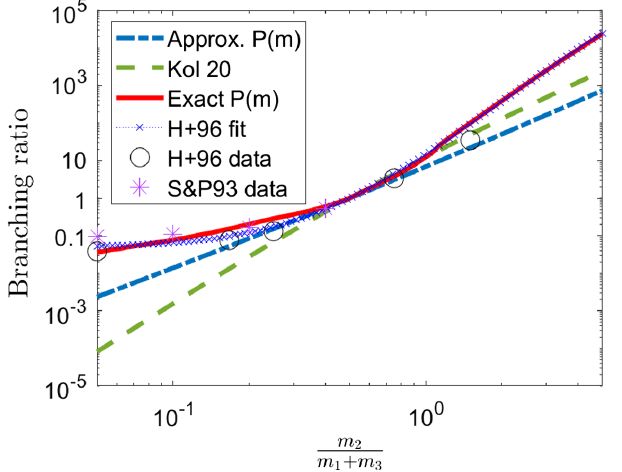
FIG. 3. Comparison between Eq. (48) and the numerical simu- interactions).FIG. 2. Predictions of Eq. (36) (sea blue, dash-dotted line), lations of Sigurdsson and Phinney [see Fig. 2(b) in Ref. [17] ]. Eq. (48) (red), integrated over the relevant range, and Eq. (A.16) The initial semimajor axis is a 0 ¼ 0 . 1 AU, and the initial of Kol [25] (green dashed line), compared with the semianalytical eccentricity is e 0 ¼ 0 ; the initial binary masses are m 1 ¼ 1 . 4 M ⊙ , fit of Heggie et al. [37] (blue, dotted with crosses) and numerical 0 . 56 M ’ s mass is m m 2 ¼ ⊙ , and the incoming third star 3 ¼ simulation data from Heggie et al. [37] (black circles) and 1 . 4 M v ffiffiffiffiffiffiffiffiffiffiffiffiffiffiffiffiffiffiffiffiffiffiffiffiffiffiffiffiffiffiffiffi p ⊙ . Its initial velocity 0 is uniformly distributed between Sigurdsson and Phinney [17] (purple asterisks). The initial binary 0 . 05 v 0 . 15 v v GM μ = ð m a . The impact c and c , where c ¼ 3 0 Þ bin masses are m 1 ¼ 1 M ⊙ and m 2 , and the incoming star ’ s mass, parameter is uniformly distributed in a disc D ð v 0 Þ at infinity, m m v 0 . 1 v v v a 4 v =v 0 . 6 ð 1 þ e 3 ¼ 1 . Its velocity is 0 ¼ c (where c is defined in the whose radius is b 0 Þ ¼ 0 ½ c 0 þ 0 Þ(cid:4) . All these max ð caption of Fig. 3) to ensure that the binary is hard. The y axis parameters were chosen to match those of Ref. [17]. We use shows the branching ratio of the cross section for ejecting m 1 β ¼ 1 . 5 , but the results are insensitive to β . The straight line relative to the cross section for ejecting m 2 . There is excellent and the data marked by blue bars pertain to the exchange agreement with Eq. ð 1 ; 2 Þ þ ð 3 Þ → ð 1 Þ þ ð 2 ; 3 Þ , while the dashed-dotted line and the data marked by purple bars are for the process ð 1 ; 2 Þ þ ð 3 Þ → ð 1 ; 3 Þ þ ð 2 Þ , where the lighter star is ejected. Error bars correspond to 3 σ statistical (Poisson) errors, arising from a total integration number of 4000 (see Fig. 9 in Ref. [17]). As expected by Sigurdsson and Phinney [17], the cutoff at large values of a is